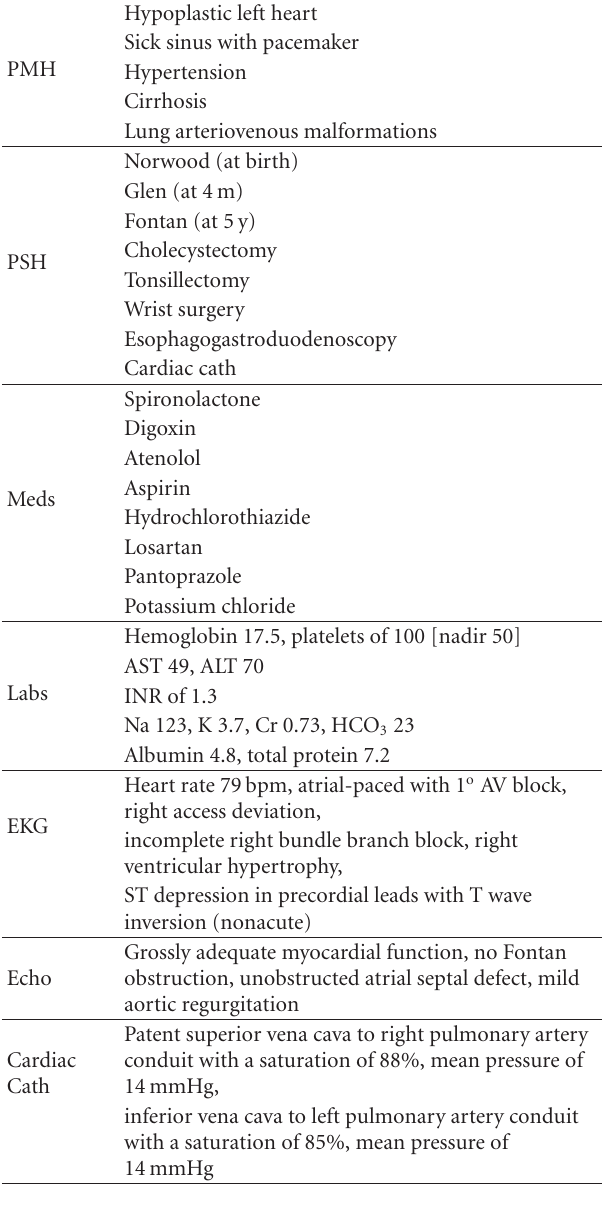
Table 1: Preoperative evaluation.